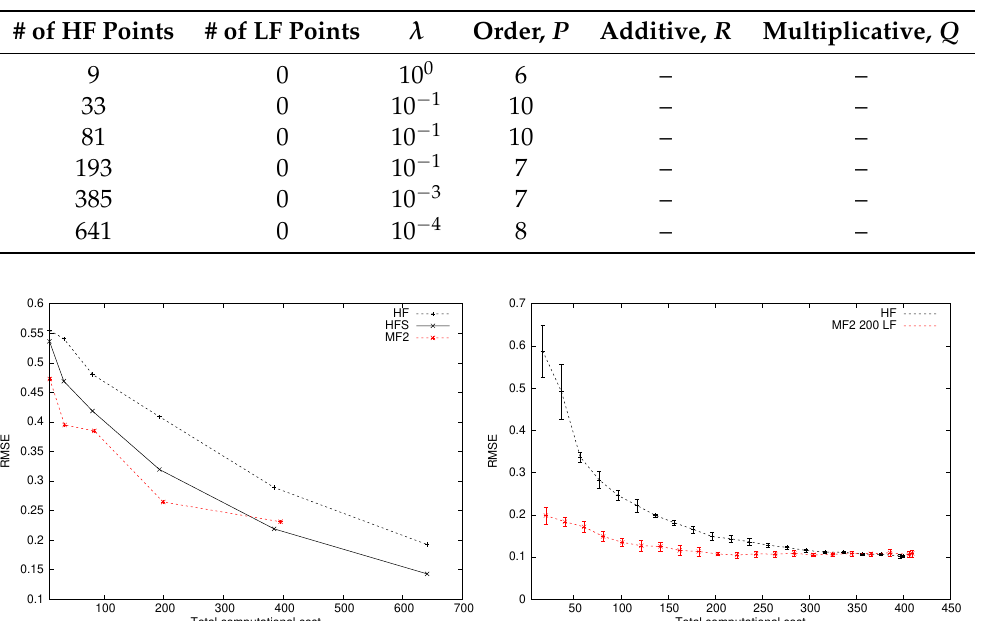
Figure 17. Spring-mass system (only springs) RMSE (from left to right, PCE and Kriging). In addition to the two-dimensional case, a four-dimensional one where both spring constants and both masses are varied between one and four was considered as well. Again, many different orders for the SPCE are combined with various values for λ to find the combination with the lowest RMSE. The resulting best values are given in Table 7, and the results are shown in Figure 18. Table 7. Best order and λ values for the four-dimensional coupled spring-mass-system using MF SPCE.